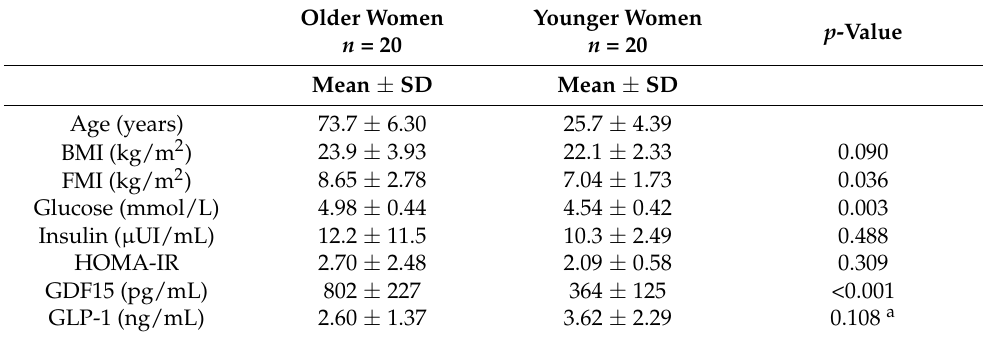
Table 1. Characteristics of study participants at baseline.